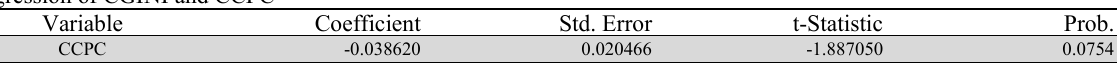
Regression of CGINI and CCPC